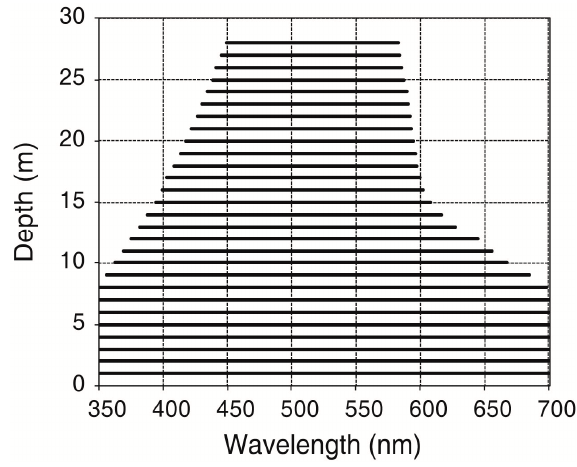
Figure 11. Maximum range of wavelength in which a substrate (composed by coral sand, green and brown algae) located at different depths can be detected with remote sensing